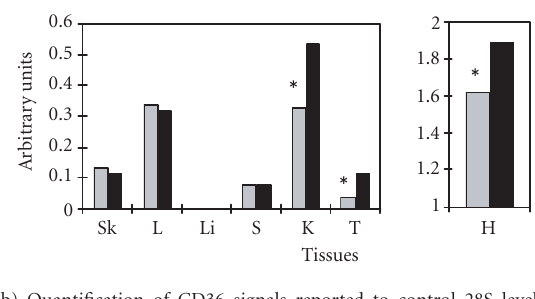
(b) Quantification of CD36 signals reported to control 28S levels. C57BL/6 is shown in light gray while the apoE is shown in black. Figure 1. Northern blot analysis of CD36 mRNA levels in di ff erent